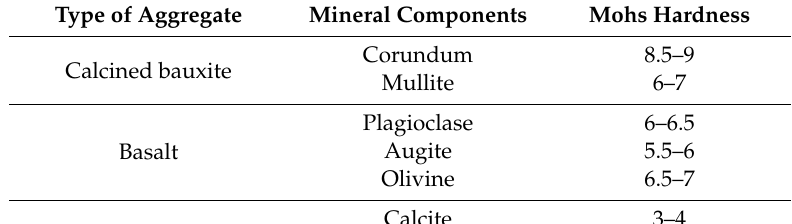
Table 5. Main mineral components and the Mohs hardness of aggregates.